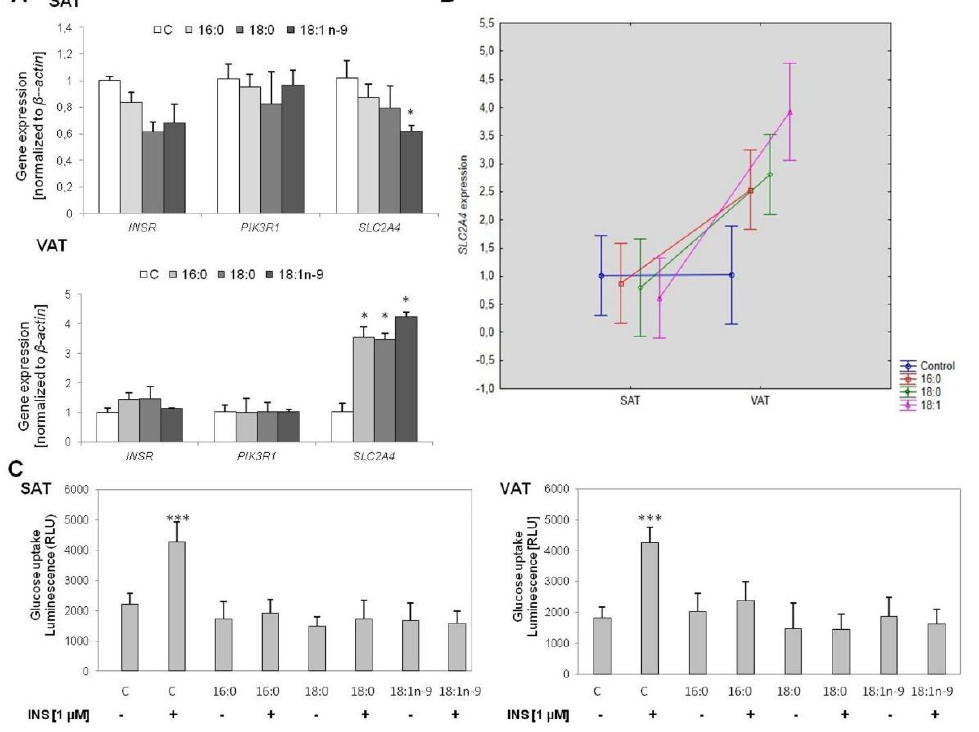
Figure 4. The expression of insulin pathway genes in SAT and VAT adipocytes. Comparison of gene expression ( A ), the various effect of the examined fatty acid excess on solute carrier family 2 member 4 ( SLC2A4 ) expression depending on fat depot ( B ) in experimental cells (treated with palmitic acid (16:0), stearic acid (18:0), and oleic acid (18:1n−9)) and control cells. Glucose uptake test after insulin stimulation ( C ) in experimental cells (treated with palmitic acid (16:0), stearic acid (18:0), and oleic acid (18:1n−9)) and control cells. (C): * p < 0.05, *** p < 0.0001.